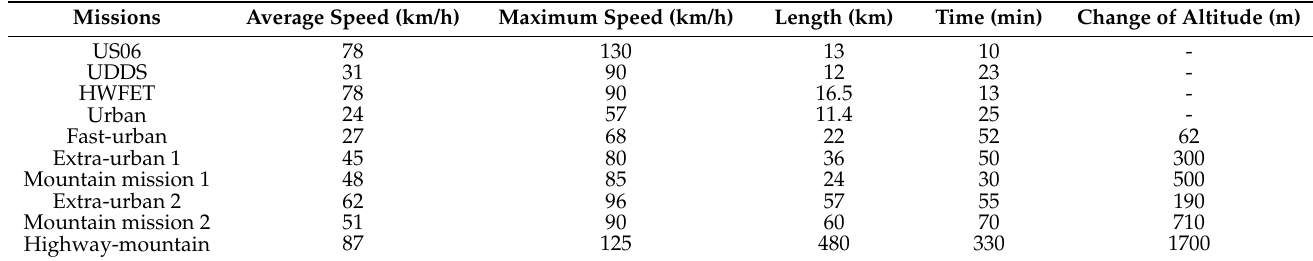
Table 3. Features of the selected road missions.